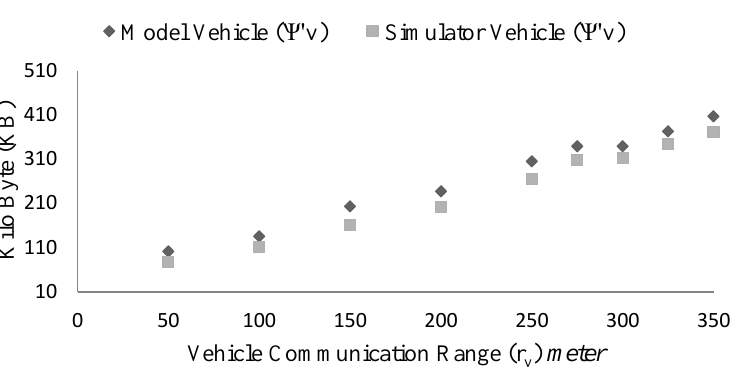
) on the vehicle storage requirements v